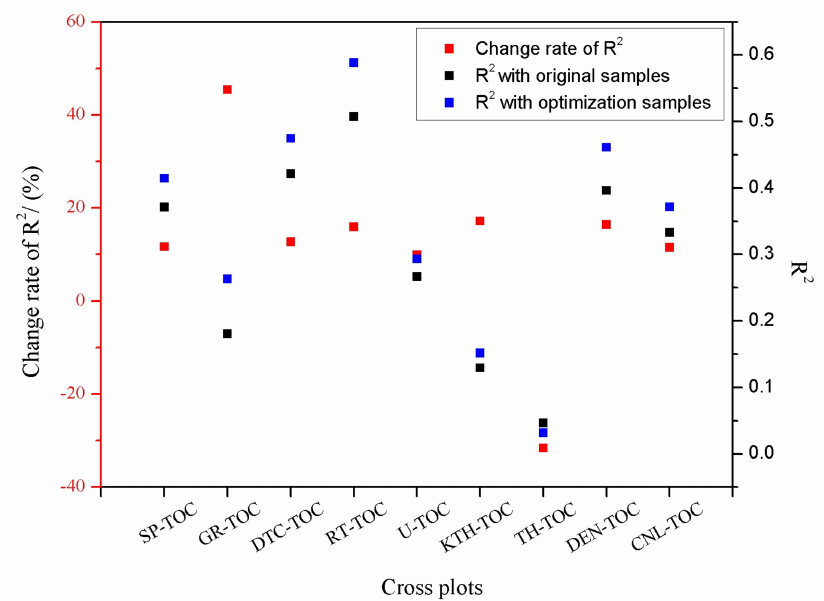
Figure 5. Change rate scattering of the R 2 after sample data